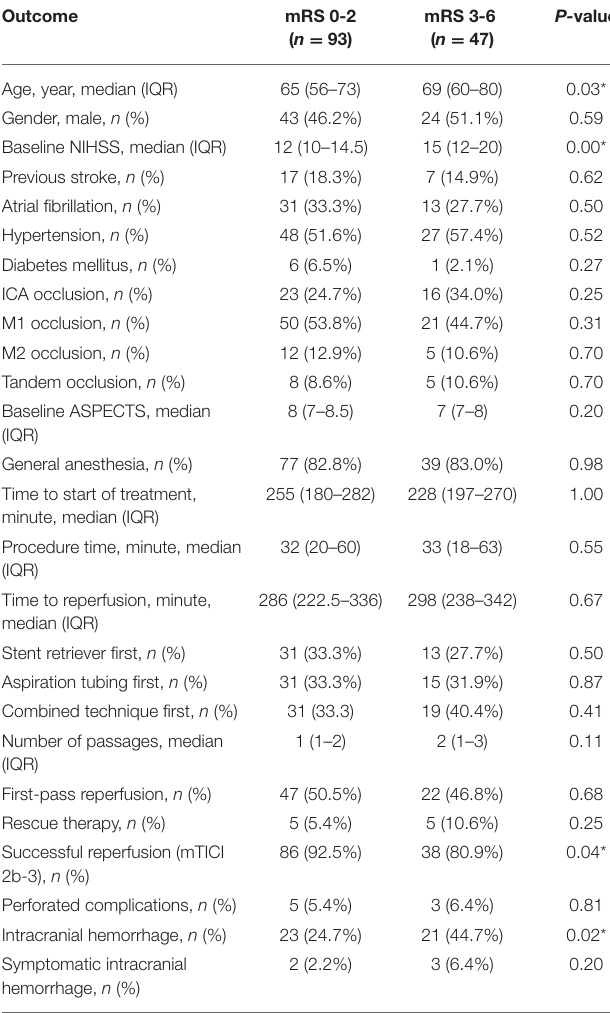
TABLE 1 | Patient characteristics and outcomes ( n = 140). Clinical characteristics